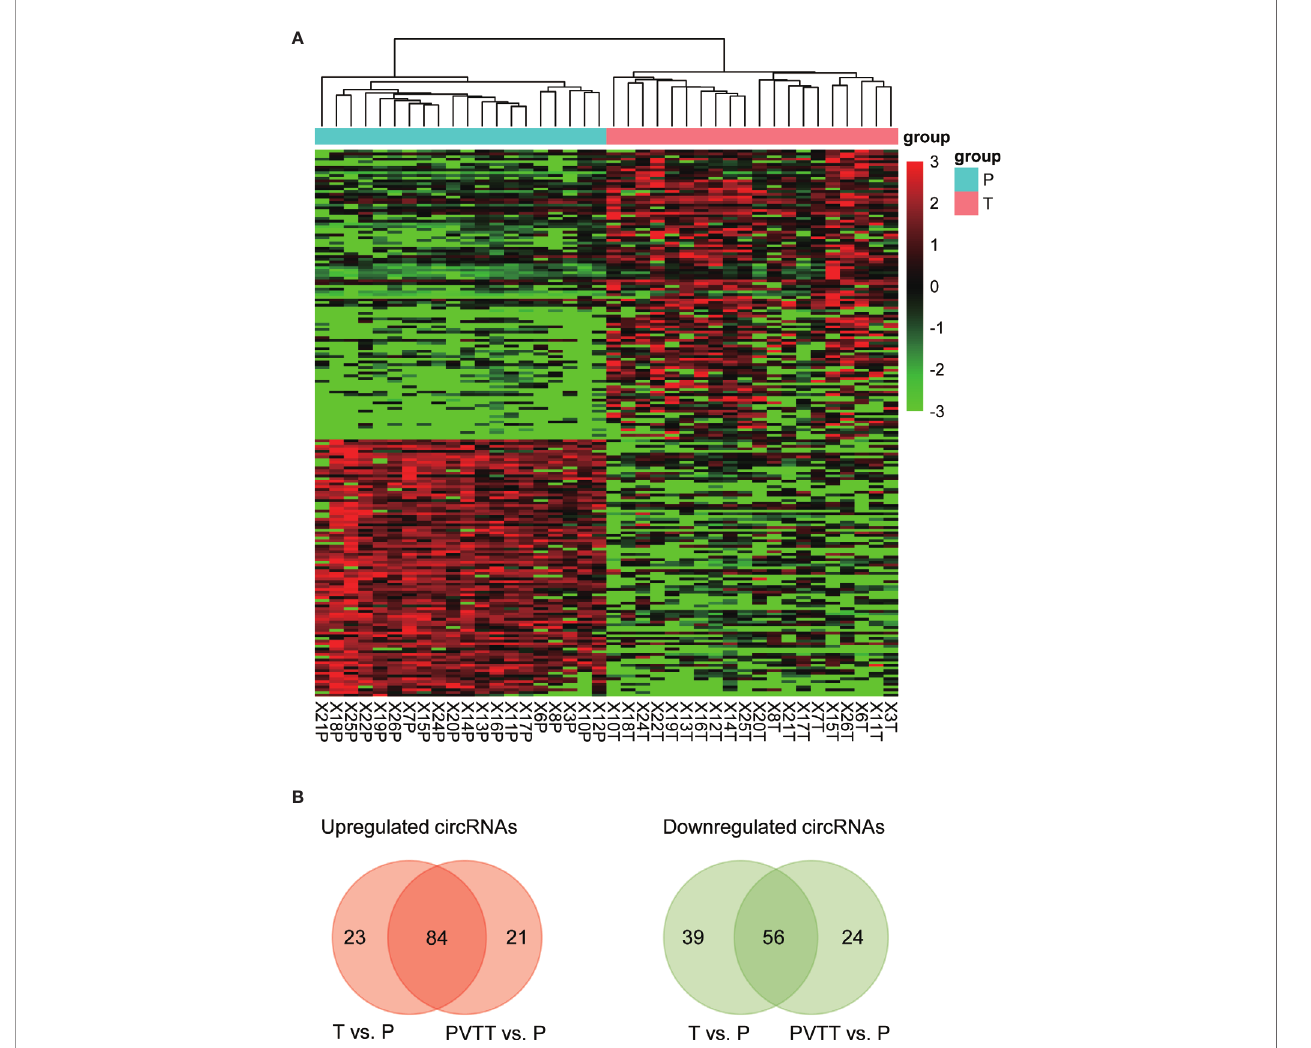
FIGURE 2 | Differentially expressed circRNAs in HCC. (A) The expression patterns of the differentially expressed circRNAs. (B) The upregulated and downregulated circRNAs that also detected to be dysregulated in PVTT.